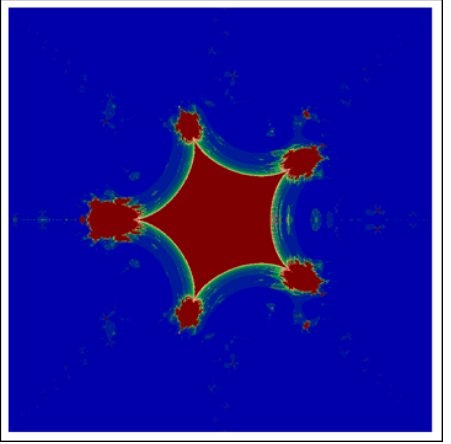
Figure 58. Multi-corn via F-iteration with image visual time = 201